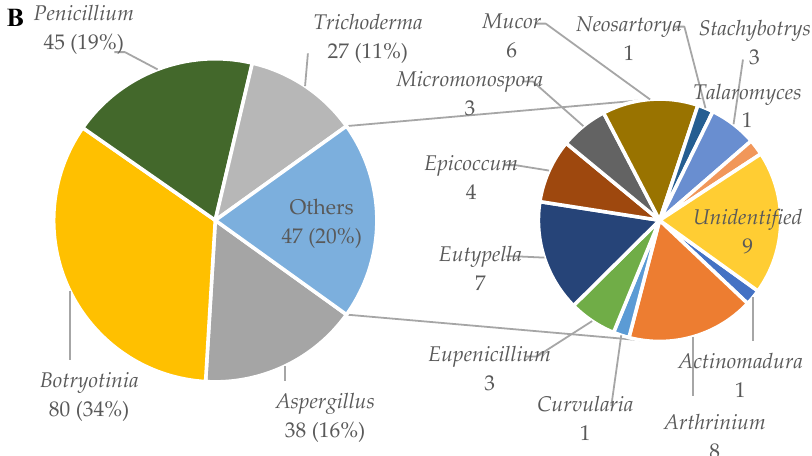
Figure 2. Distribution of the number of papers reporting marine fungi-derived diterpenes ( A ) and the number of diterpenes ( B ) by fungal genus.